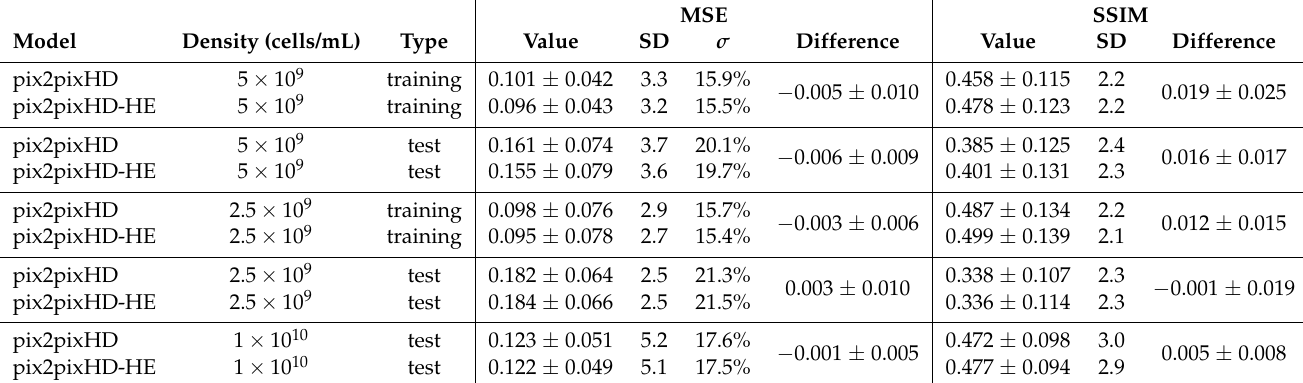
Table 2. Model performance after histogram equalization. SD—spatial displacement/ µ m; σ —minimal standard deviation for added Gaussian noise, given as a percentage of original intensity